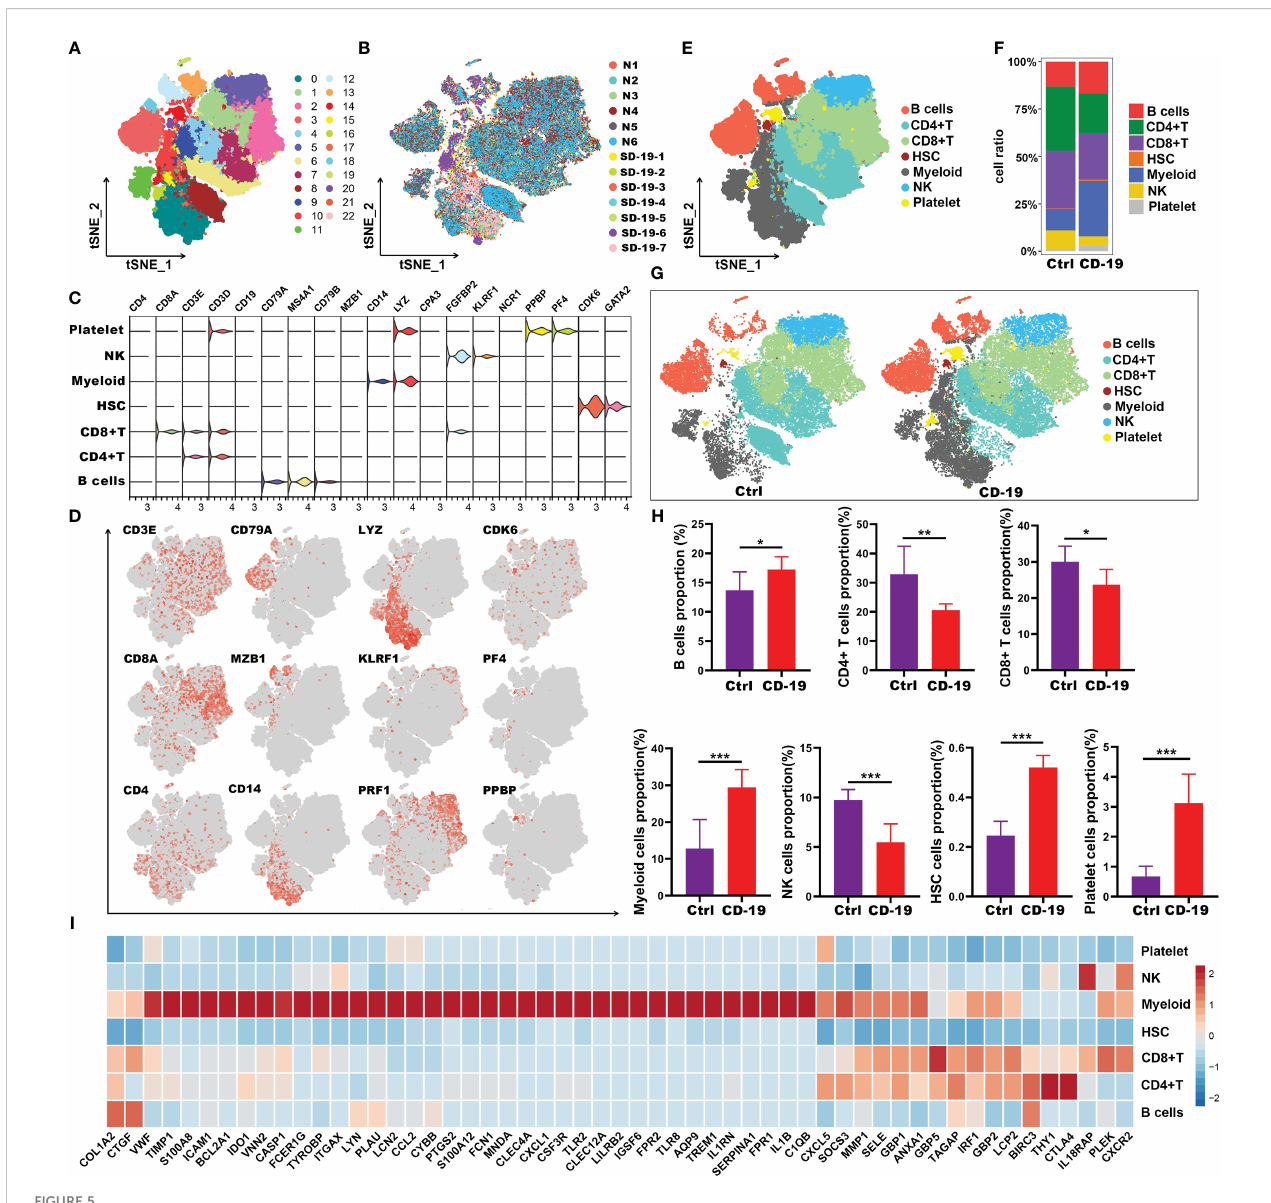
FIGURE 5 Immune characteristics of the hub genes at the single-cell resolution in PBMCs of COVID-19. (A, B) t-SNE plot displaying 63,314 immune cells from 13 samples; color denotes cluster origin (A) and sample origin (B) . (C) Violin plots showing expression levels of speci fi c markers for platelets, NK, myeloid cells, HSC, CD8 + T, CD4 + T and B cells. (D) t-SNE plots demonstrating the expression of selected marker genes in different cell types. (E) t-SNE plot representation of the major cell types of COVID-19 PBMCs. (F) Proportion of each cell types in COVID-19 and healthy individuals. (G) t-SNE plot representation of each cell types in COVID-19 and healthy individuals. (H) Proportion of each cell types between COVID-19 and healthy controls. (I) Heatmap showing expression patterns of hub genes in each cell types. * p < 0.05; ** p < 0.01; *** p < 0.001; ns, not signi fi